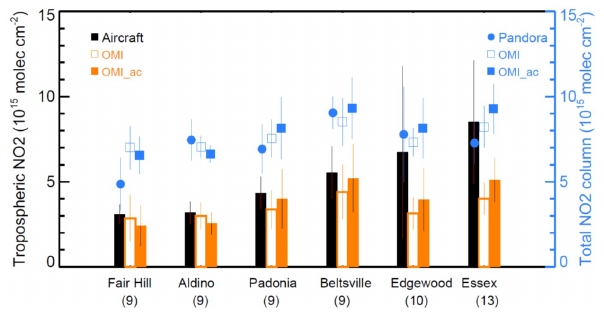
Figure 16. Comparison of average tropospheric (orange bars) and total (blue squares) NO 2 columns determined from in situ aircraft (black bars) measurements and total columns retrieved from Pan- dora (filled blue circles) at the six locations in Maryland during the DISCOVER-AQ field campaign (from Lamsal et al., 2014). Open bars and squares represent the operational retrievals and filled bars and squares represent the retrievals performed using collocated aircraft-measured NO 2 vertical profiles. The vertical lines represent the standard deviation of the average.